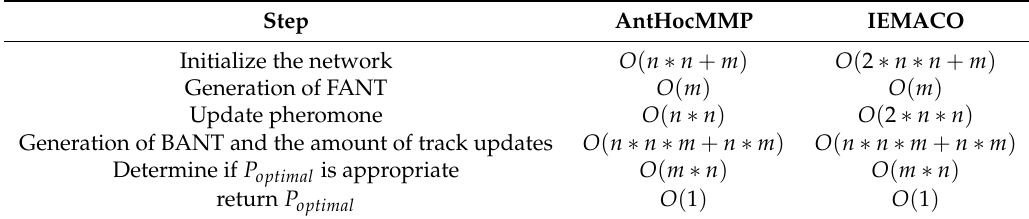
Table 2. Time complexity.